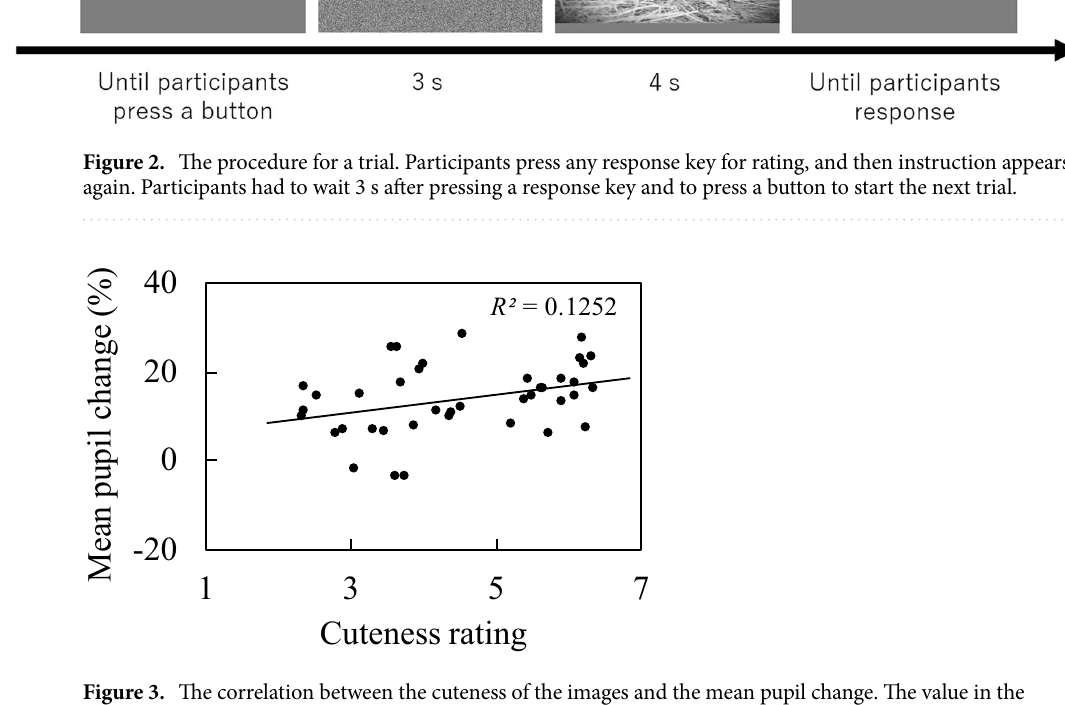
Figure 3. The correlation between the cuteness of the images and the mean pupil change. The value in the upper right corner of the panel indicates the coefficient of